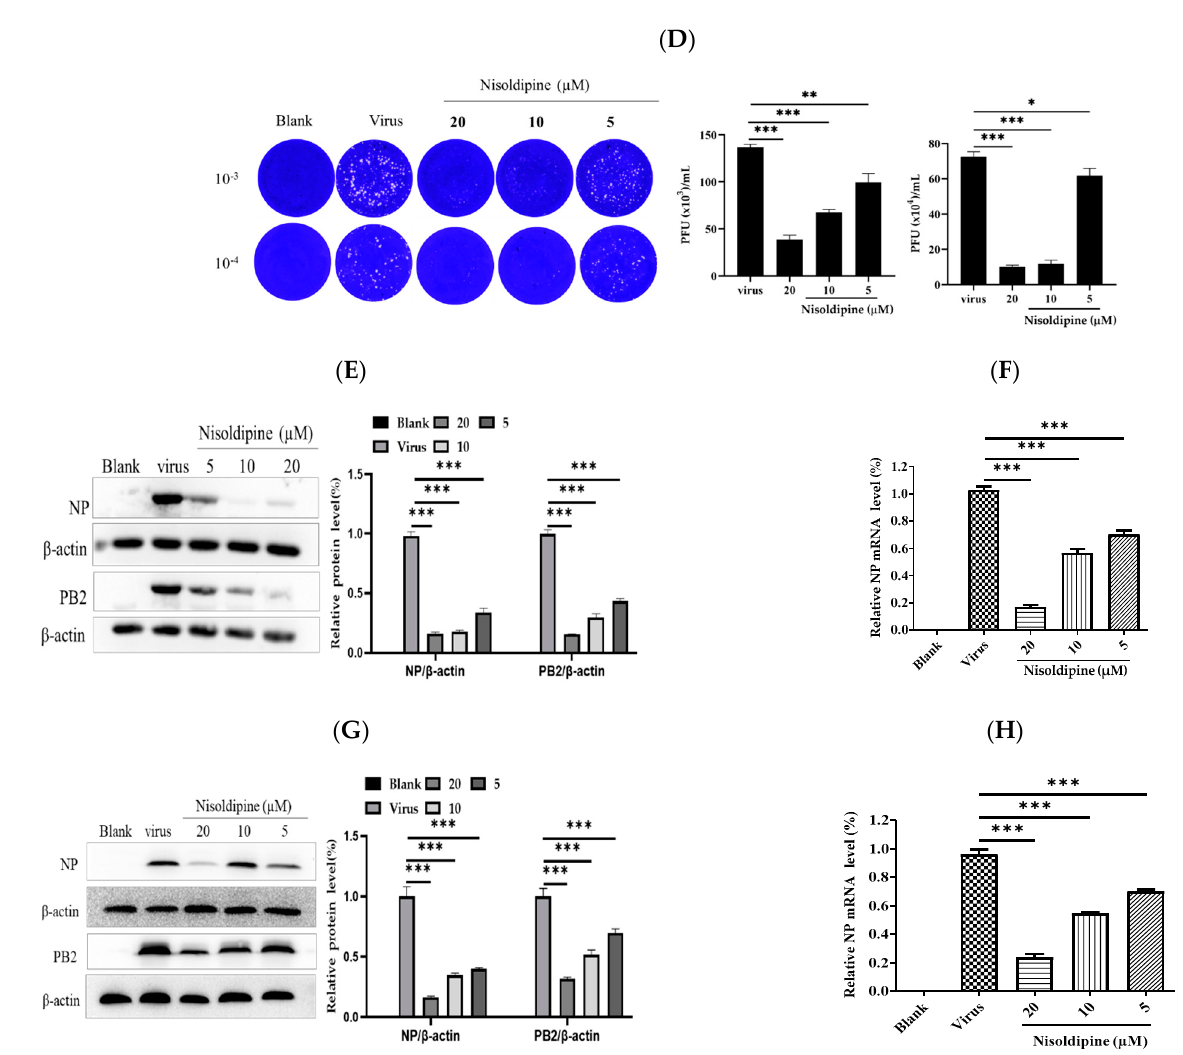
Figure 1. The effect of nisoldipine on the replication of IAV. ( A ) The chemical structure of nisoldipine. ( B ) Nisoldipine reduced virus-induced CPE in MDCK cells. Images of the cells were acquired at 4 × magnification at 48 h post-infection. ( C ) Nisoldipine could dose-dependently reduce the formation of viral plaques. ( D ) The production load of progeny virus in the supernatant. The supernatants were diluted 1000 or 10,000 times, and virus titers were determined by means of plaque assays on MDCK cells. ( E , F ) The expression level of the viral protein and gene could also be restrained by nisoldipine in a dose-dependent manner in MDCK cells. ( G , H ) The expression level of the viral protein and gene could also be restrained by nisoldipine in a dose-dependent manner in A549 cells (* p < 0.05, ** p < 0.01, *** p < 0.001).